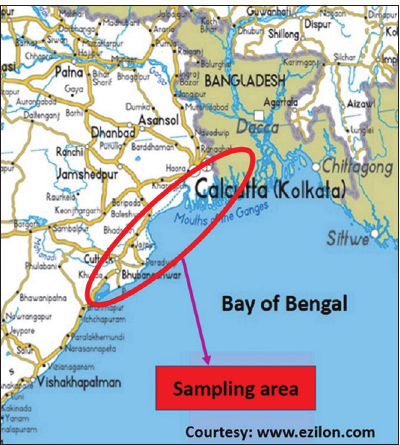
Figure-1: Location of sampling